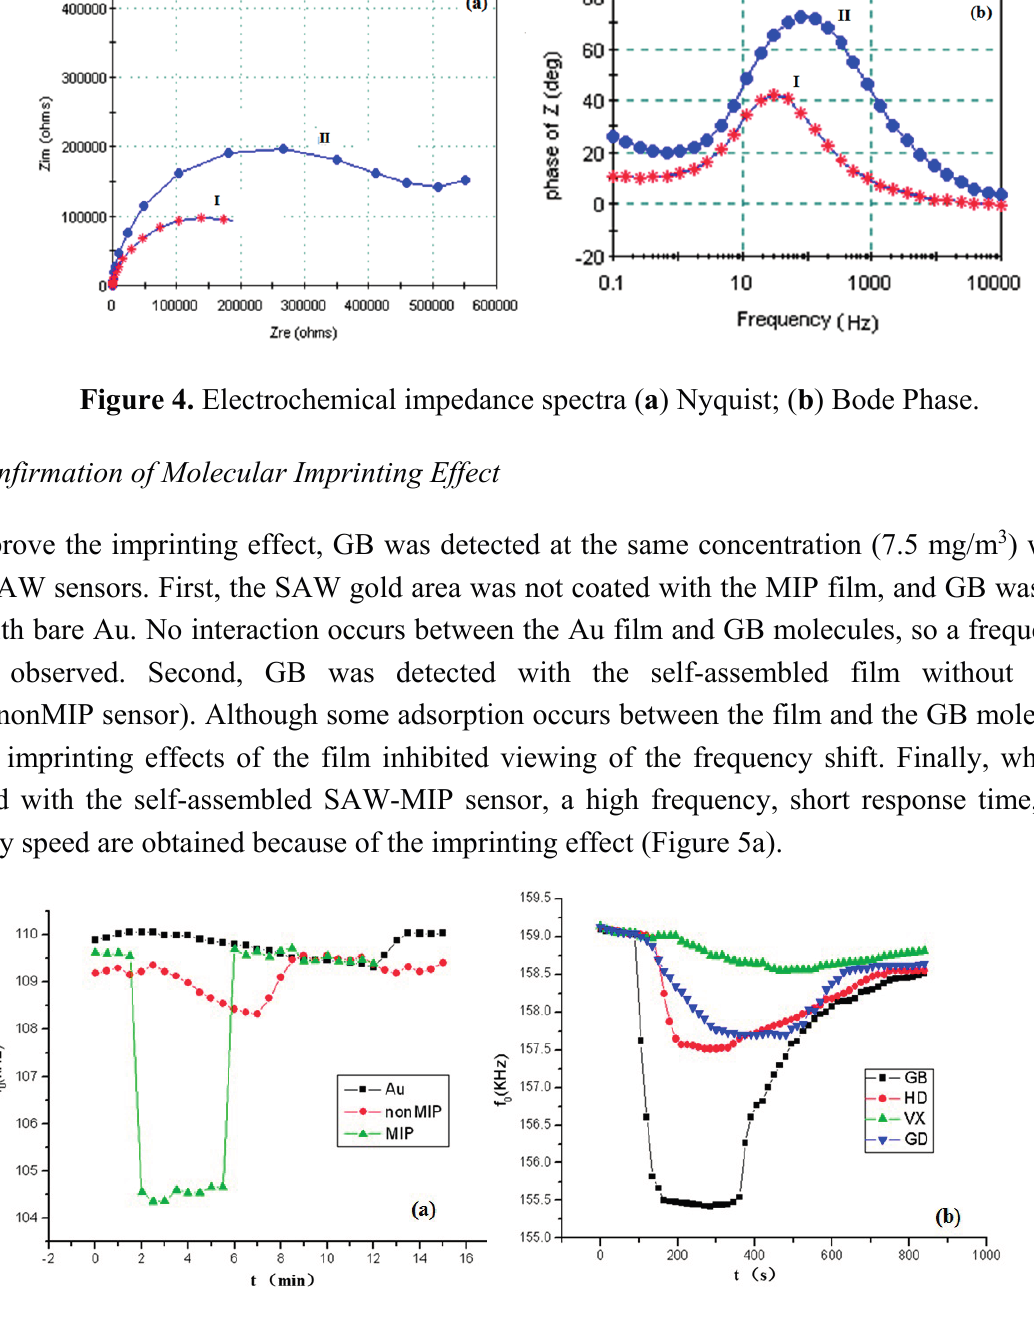
Figure 5. Confirmation of MIP effect ( a ) Detection of GB by three kinds of sensors; ( b ) Detection of different warfare agents by MIP